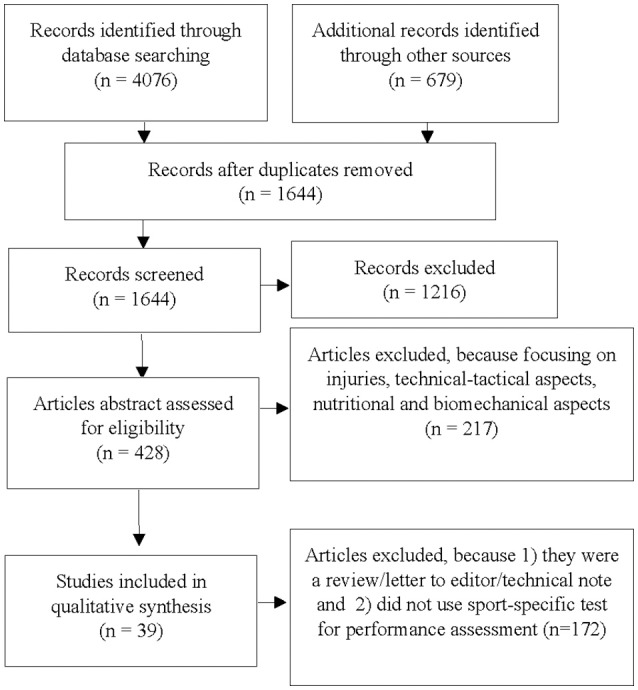
Flow of information through the different phases of the systematic review.